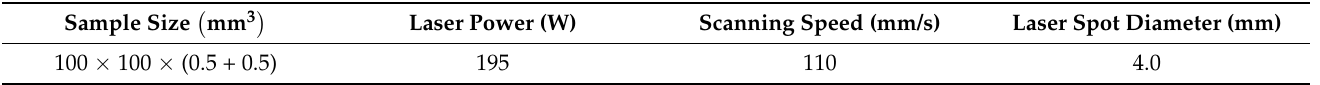
Table 1. Processing parameters for the high speed LITP dicing of the silicon/glass double layer